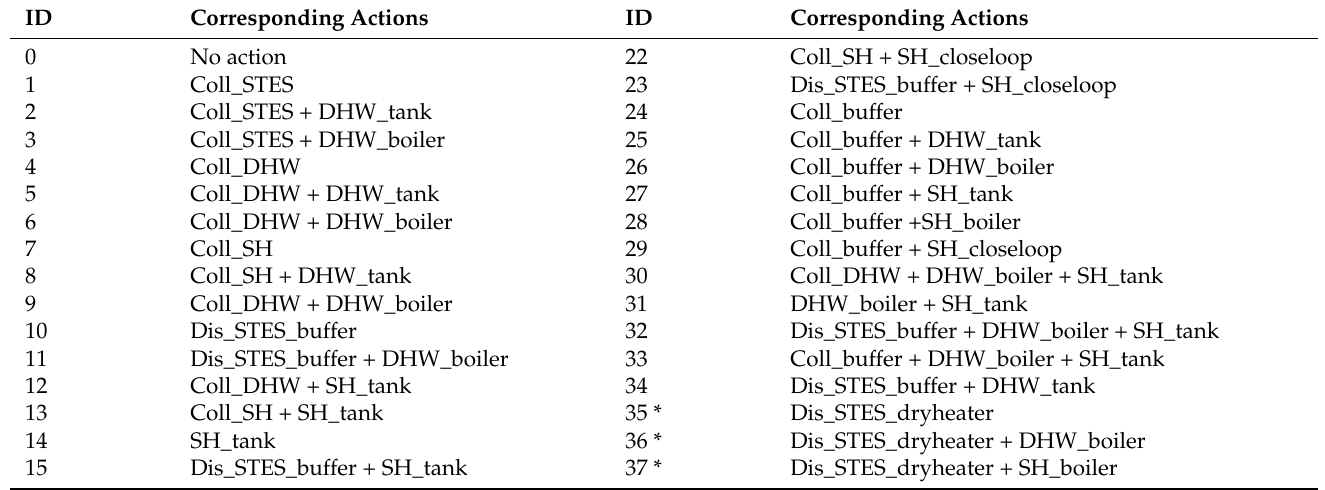
Table A1. System operational